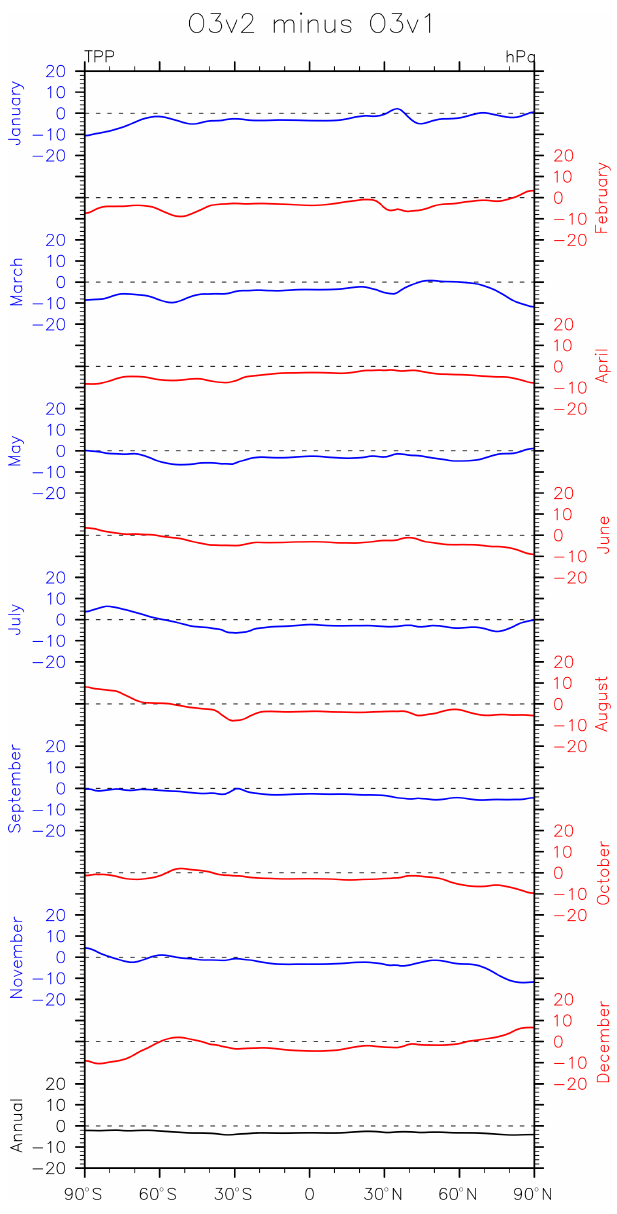
Figure 9. Zonal mean tropopause changes between O3v2 and O3v1 for annual and monthly means.